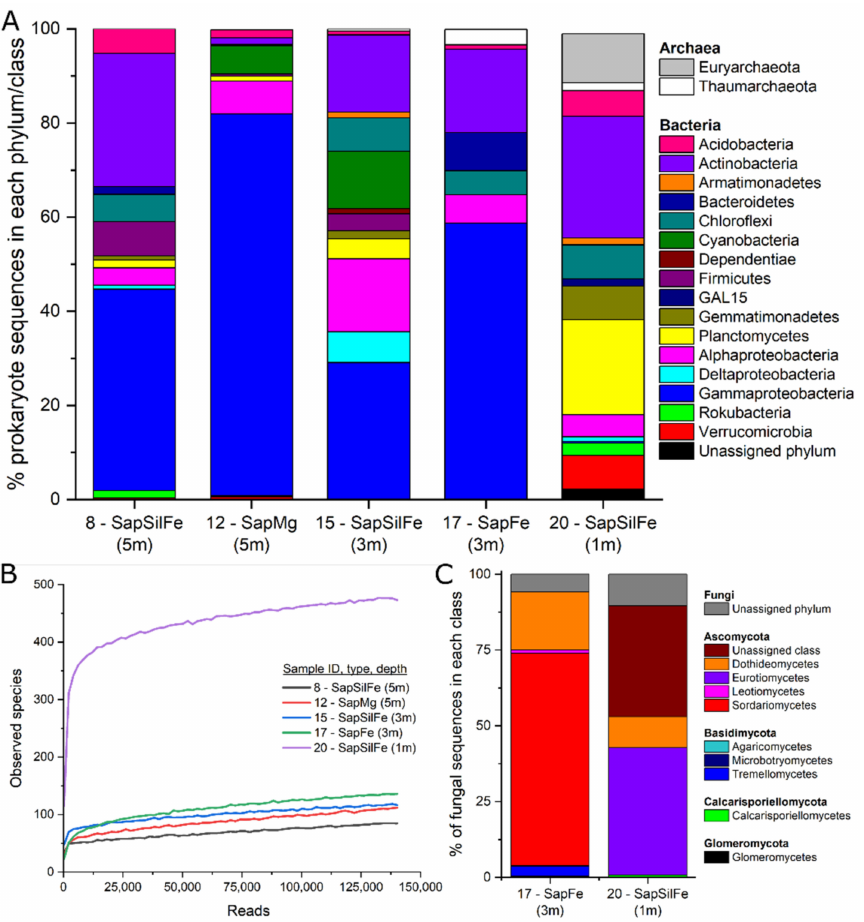
Figure 19. ( A ) Prokaryote community composition at the phylum/class level, sequences > 1% in at least one sample shown. ( B ) Rarefaction curve for prokaryotes. ( C ) Fungal community composition at the class